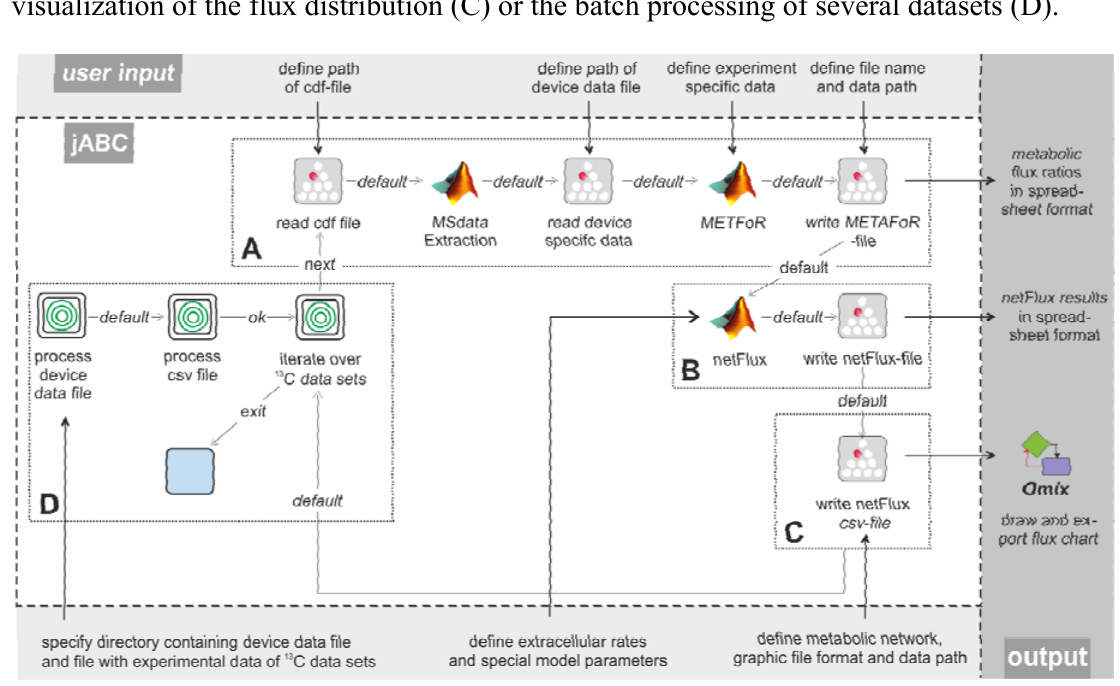
Figure 3. Example workflows for customized 13 C-based MFA: box A shows a basic workflow for the calculation of metabolic flux ratios of one single dataset. This workflow can easily be extended to fit the user's needs, e.g. to enable net flux calculations (B), visualization of the flux distribution (C) or the batch processing of several datasets